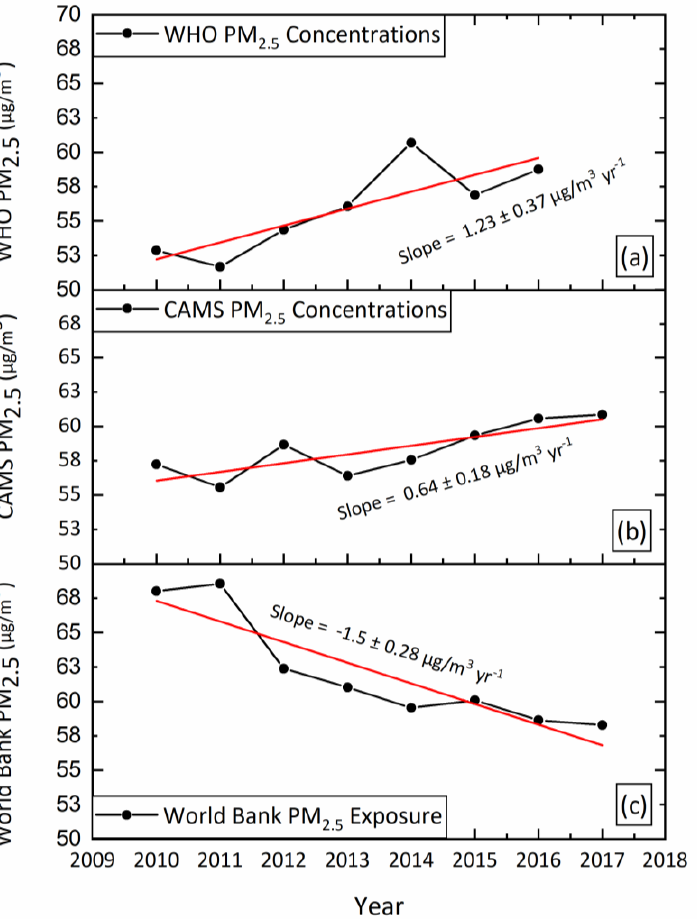
Figure 1. Time series of PM 2.5 concentrations obtained from ( a ) the WHO database (2010 – 2016) and ( b ) CAMS reanalysis data (2010 – 2017). ( c ) PM 2.5 exposure was obtained from the World Bank data- and ( b ) CAMS reanalysis data (2010–2017). ( c ) PM 2.5 exposure was obtained from the World base (2010 – 2017). PM 2.5 concentrations from the WHO website were not available for 2017.